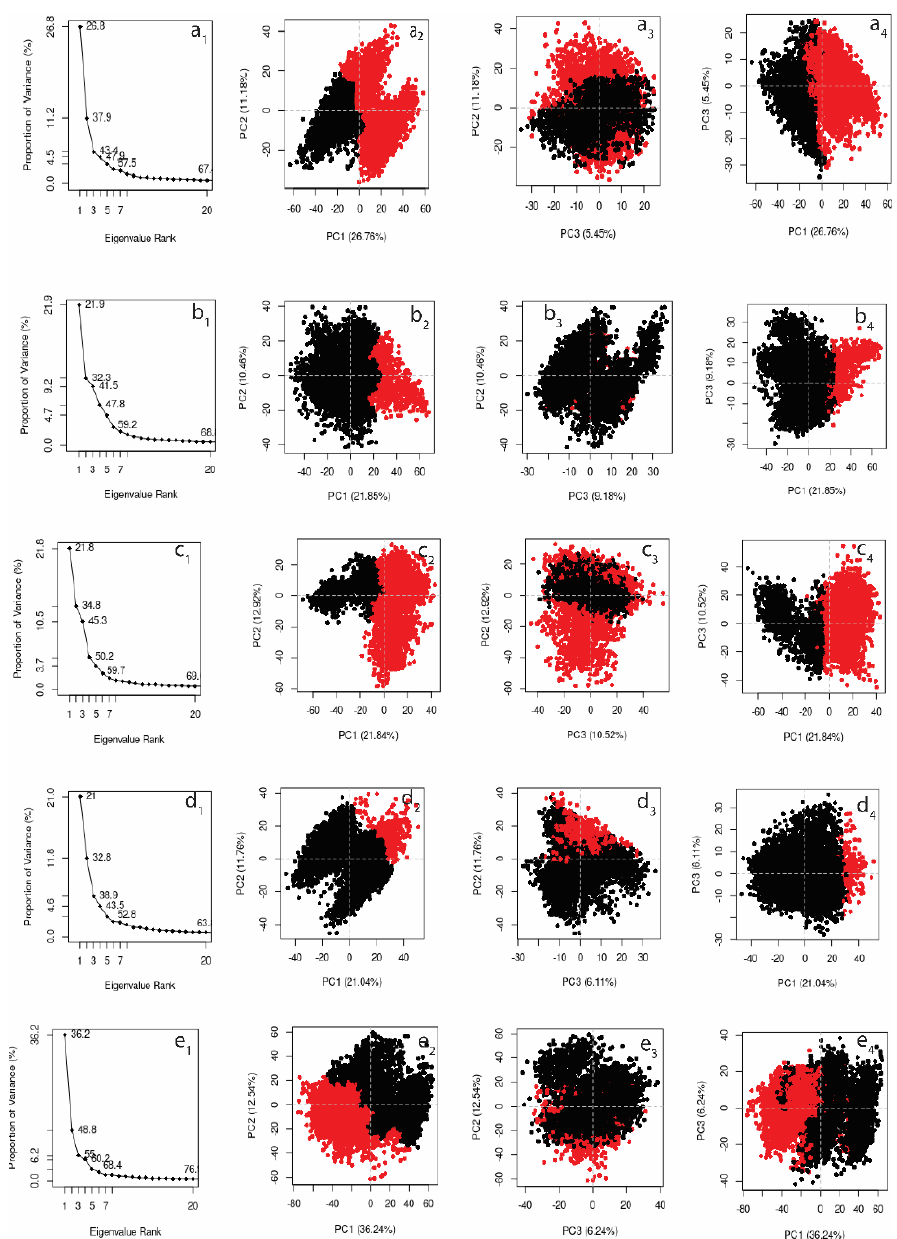
Figure 9. Principal component cluster analysis along the first three eigenvectors for ( a 1 – a 4 ) desmo- pressin, ( b 1 – b 4 ) rutin, ( c 1 – c 4 ) lypressin, ( d 1 – d 4 ) lanreotide, and ( e 1 – e 4 ) the native ligand 68T. Red and black show the cluster formation.